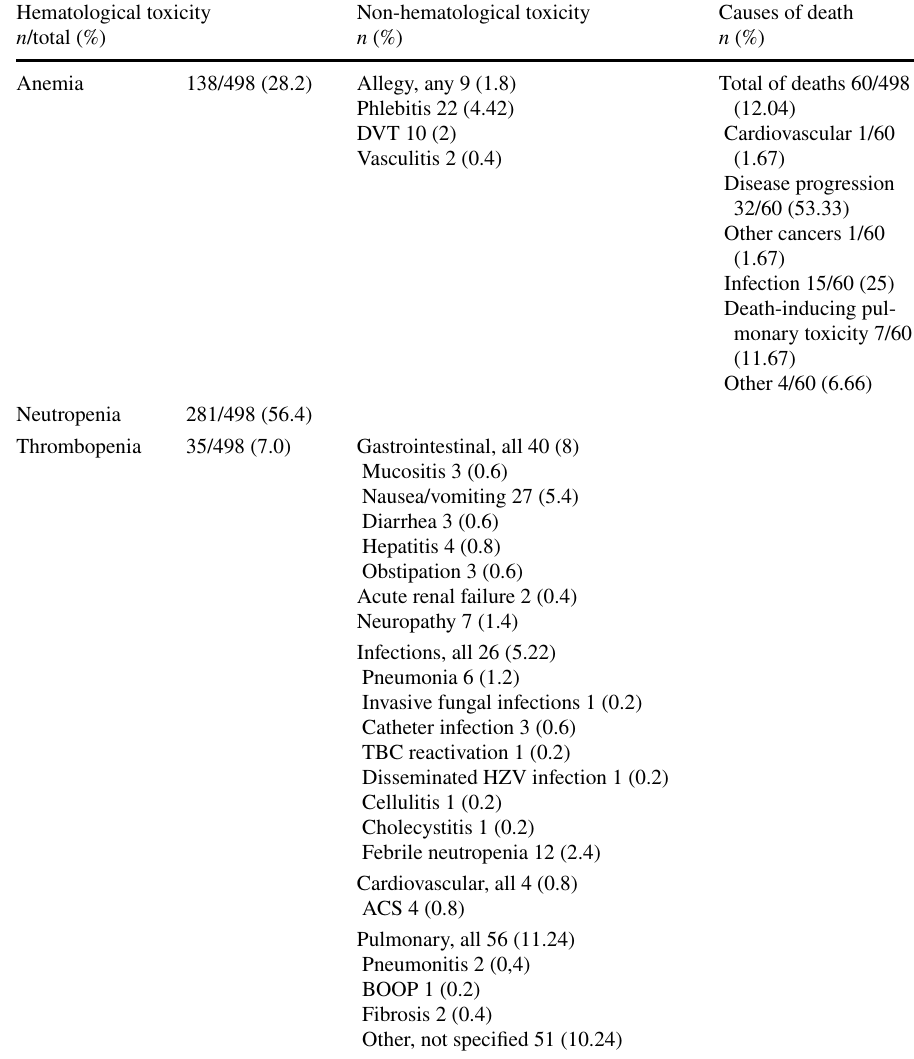
Table 3 Treatment related toxicity and causes of